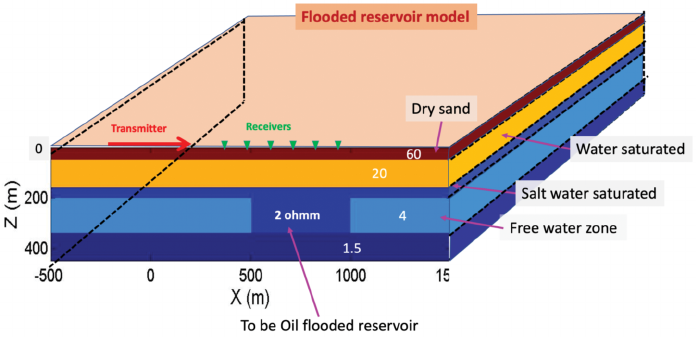
Figure 17. Simplified geologic model of a heavy oil (HO) reservoir. The HO section is the reservoir shown here as salt water saturated.